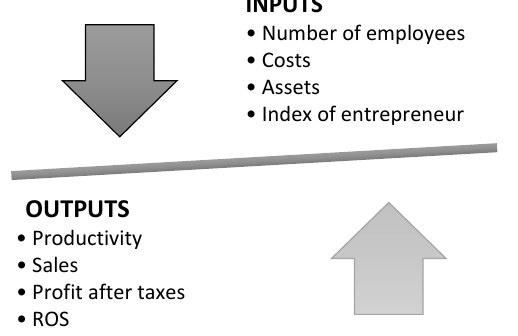
Figure 4. Model 3. Strategy “customer relationships”